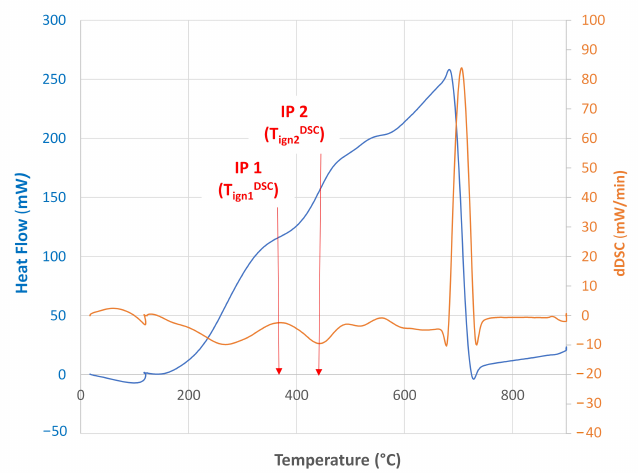
Figure 3. The DSC profile for the tested SA_4